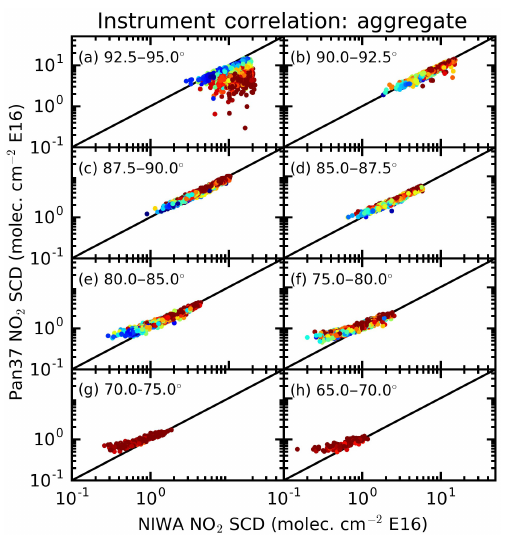
Figure 3. Correlation plots for data collected by the Pandora and M07 instruments. Data were resampled to 5-minute averages and color coded according to SZA within the specified bin range (i.e., red represents the upper SZA limit and blue represents the lower bounds for each sub-panel). Values within the figure legends indi- cate SZA